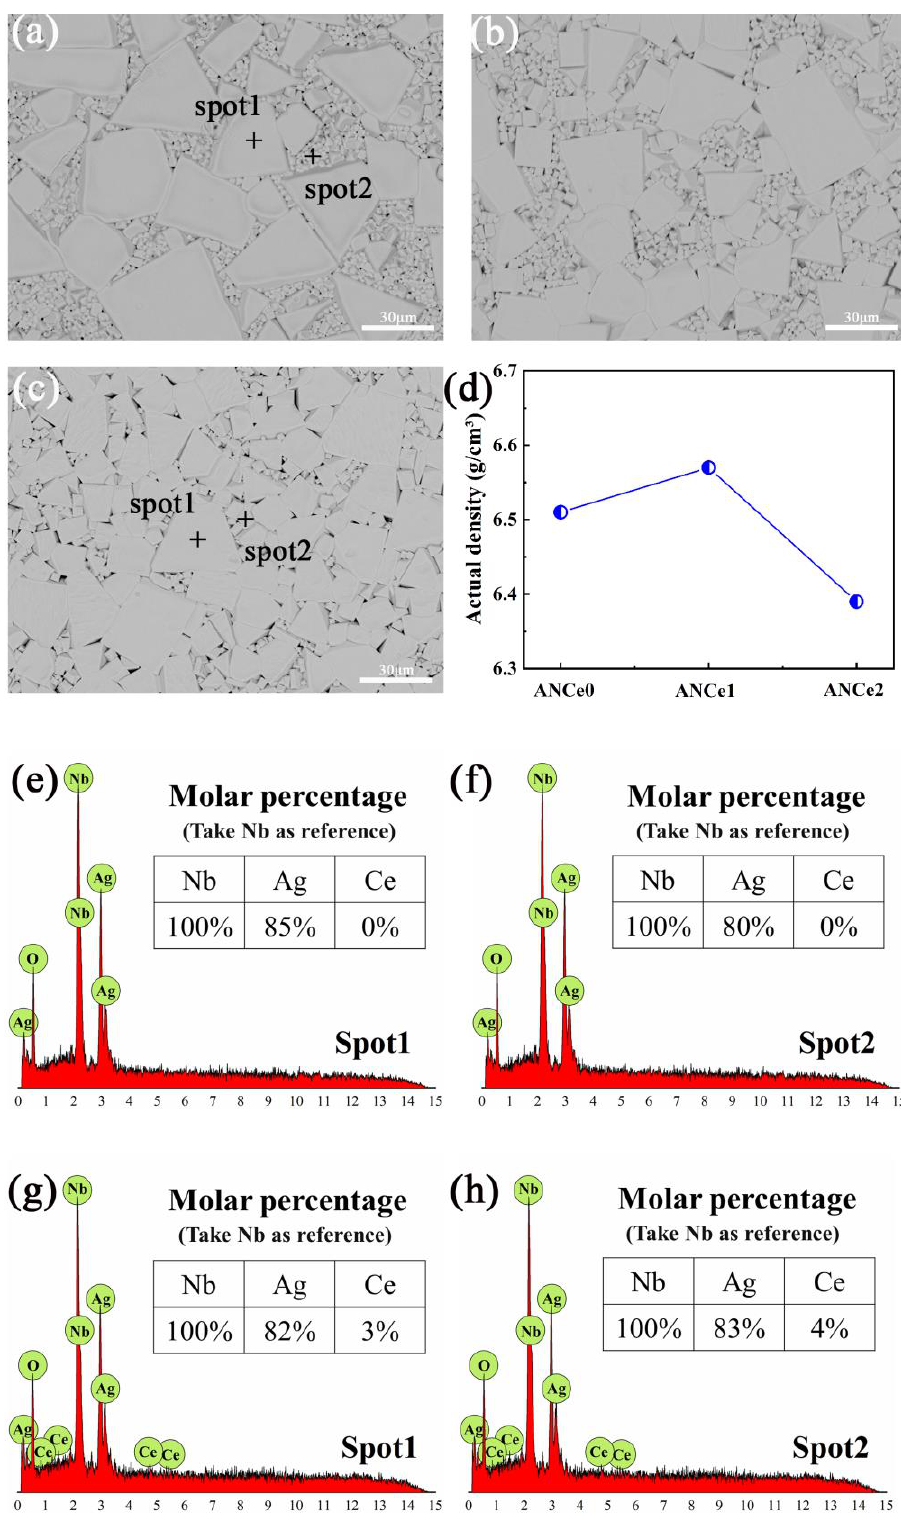
Figure 2. SEM images, the actual density, and EDS results of ANCe x ceramics. SEM images of ( a ) ANCe0, ( b ) ANCe1 and ( c ) ANCe2 ceramics, and ( d ) The actual density of ANCex ceramics. EDS results of ( e , f ) ANCe0 and ( g , h ) ANCe2 ceramics.